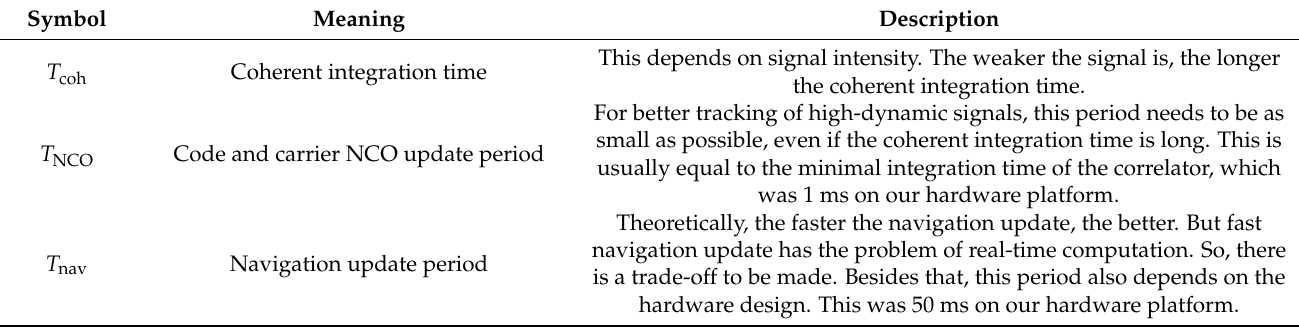
Table 1. Summary of three basic time periods in VTL.